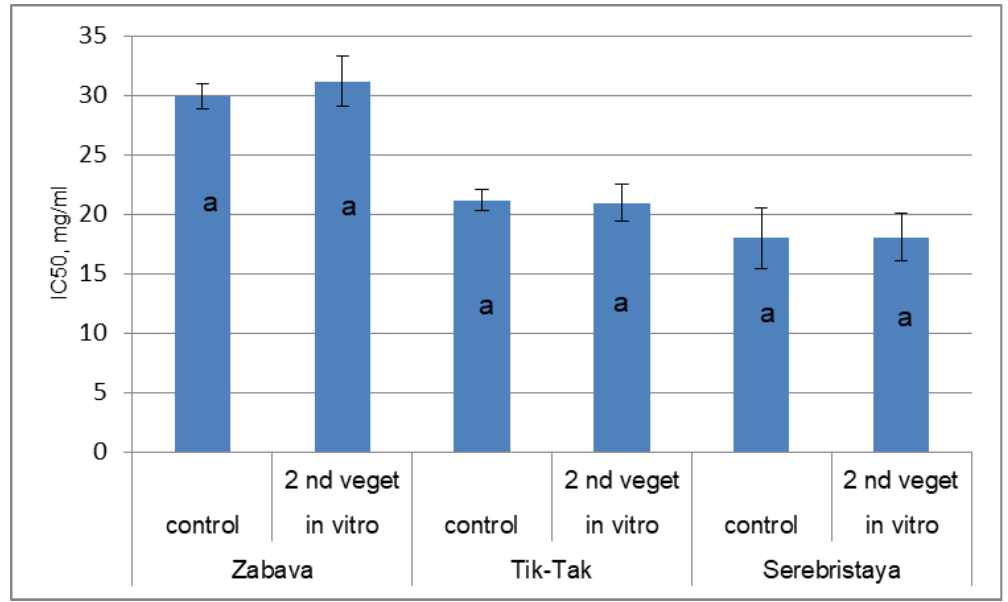
Figure 4. Antioxidant activity of the EOs in peppermint cultivars depending on the growing conditions, IC 50 (mg · mL − 1 ). 2nd veget—second vegetation year. Values followed by the same letter (a) were not significantly differed for each variant ( p ≤ 0.05).